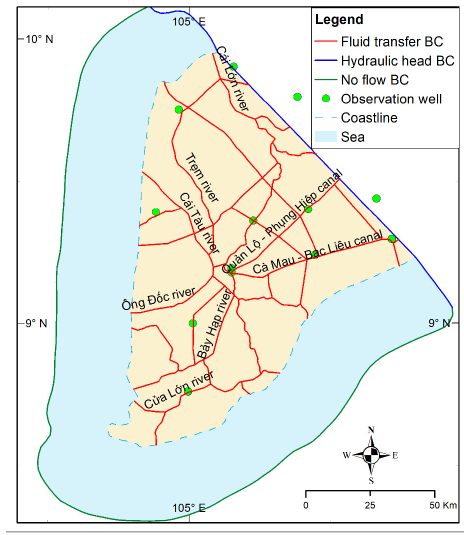
Figure 6. Boundary conditions in the model.